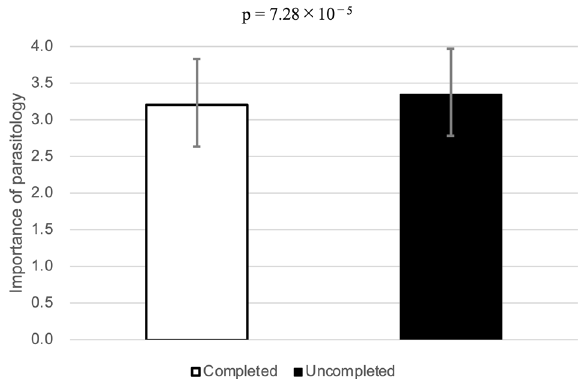
Fig. 1 Comparison of the perception of importance before and after the parasitological course. Students who had taken parasitology ( n = 525) and those who had not ( n = 518) were asked how importantly they perceived parasitology. The students were asked to rate the importance of parasitology on a four-point scale (4 = “ very important ” and 1 = “ not important at all ” ).